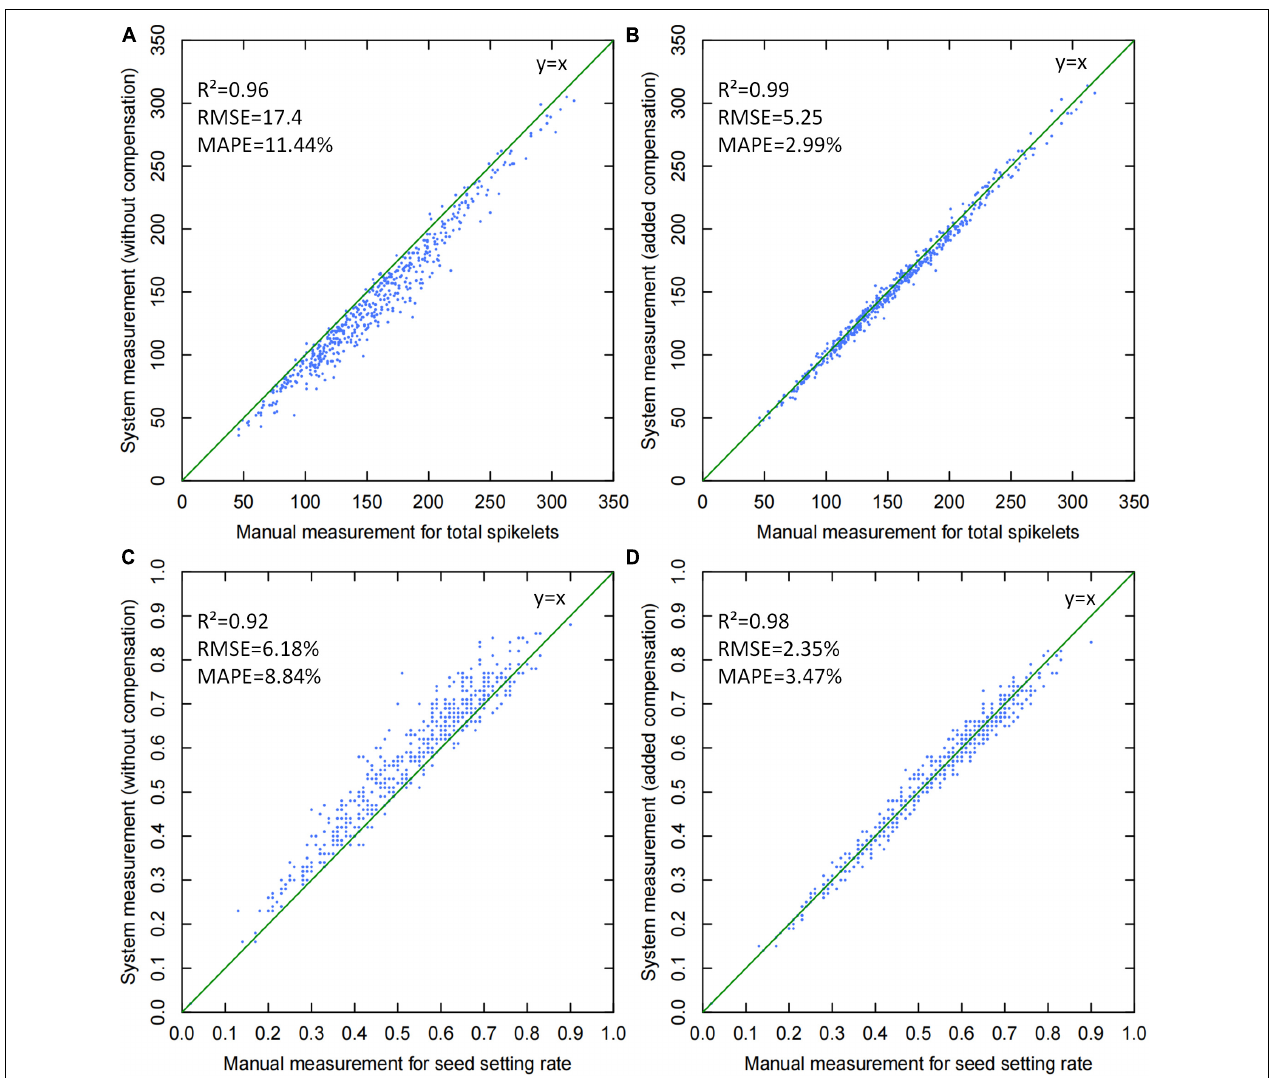
FIGURE 9 | Scatter plots of manual versus system measurements for yield-related trait evaluation: (A) total spikelet measurement without threshed panicle compensation, (B) total spikelet measurement with threshed panicle compensation, (C) seed setting rate measurement without threshed panicle compensation, and (D) seed setting rate measurement with threshed panicle